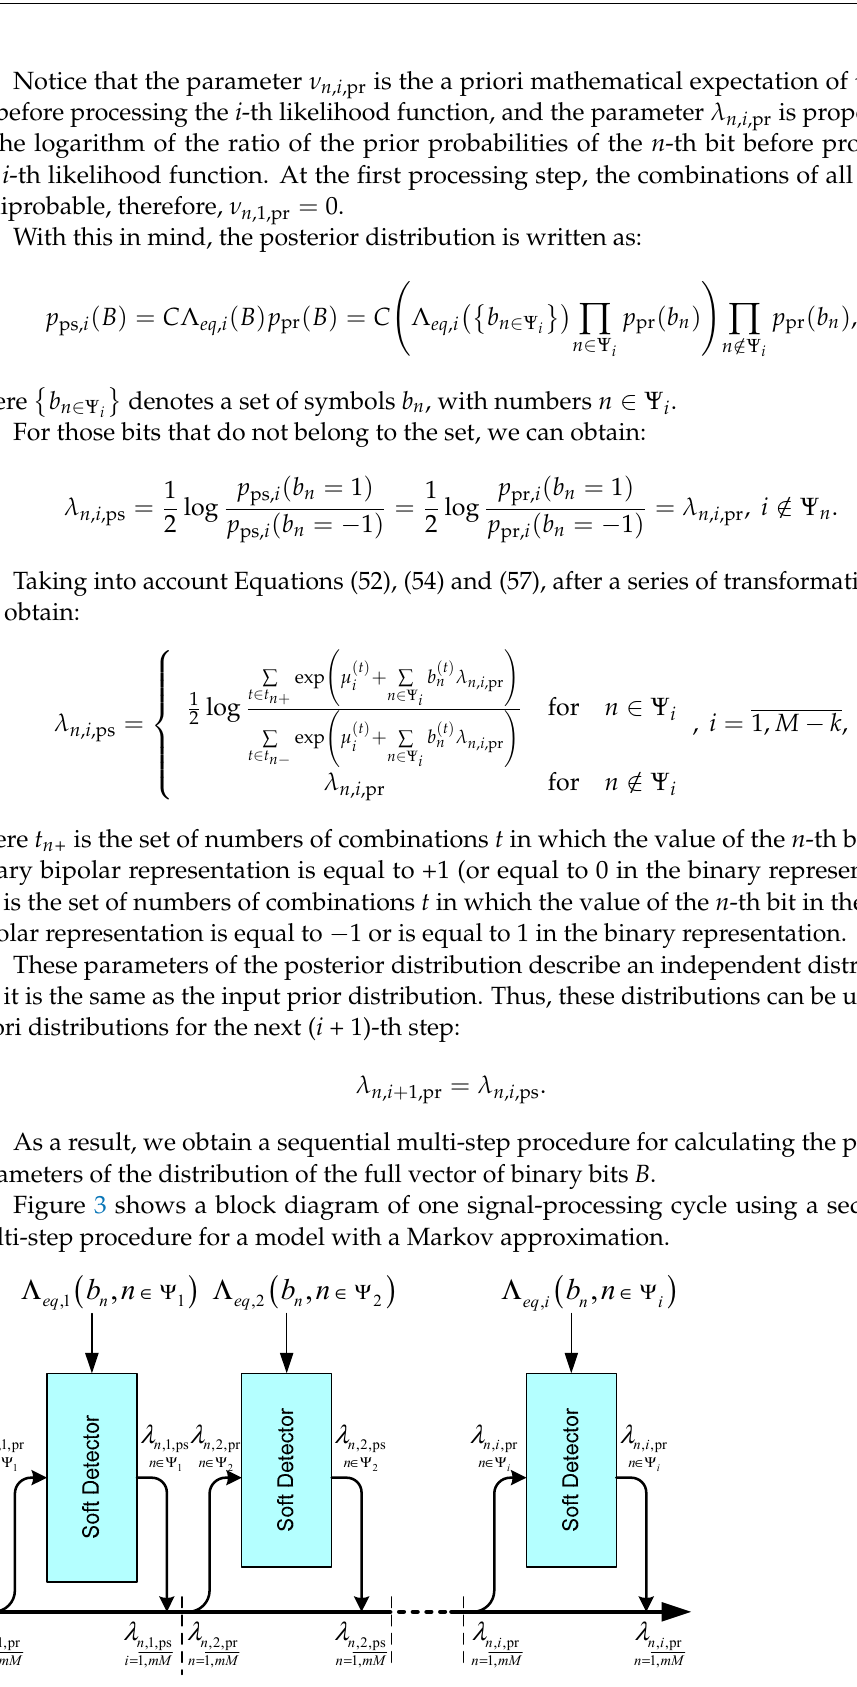
Figure 3. Block diagram of signal processing using a sequential multi-step procedure for a model with Markov approximation.